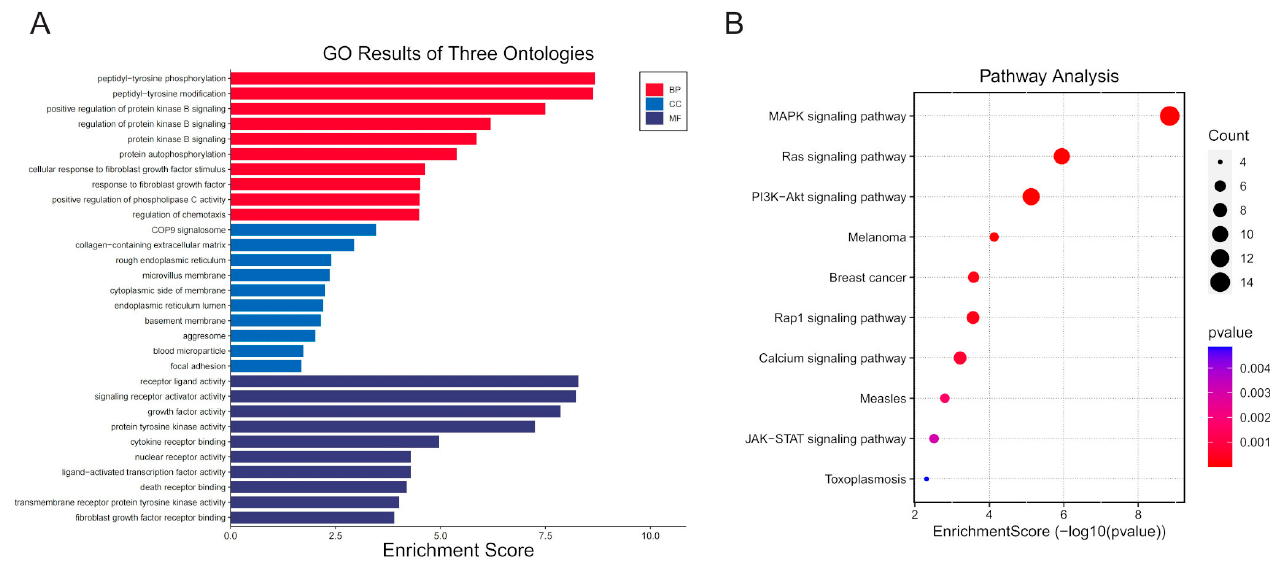
Figure A3. ( A,B ) The first 10 Go and KEGG enrichment pathways of 74 genes in brown Figure A3. The first 10 Go and KEGG enrichment pathways of 74 genes in brown module.